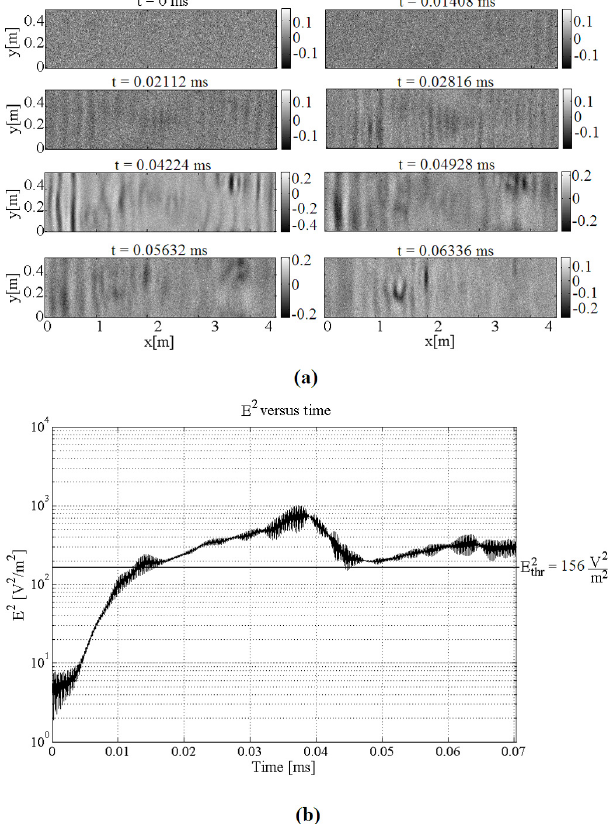
Fig. 10. (a) Snapshots of the ion density variation for simulations with parameters presented in Sect. 3.3 ( n e = 10 12 m − 3 ). (b) Mag- nitude squared electric field E 2 t versus time for simulation with pa- rameters presented in Sect. 3.3. Fig. 11. (a) Incoherent scatter spectrum and (b) ion acoustic line